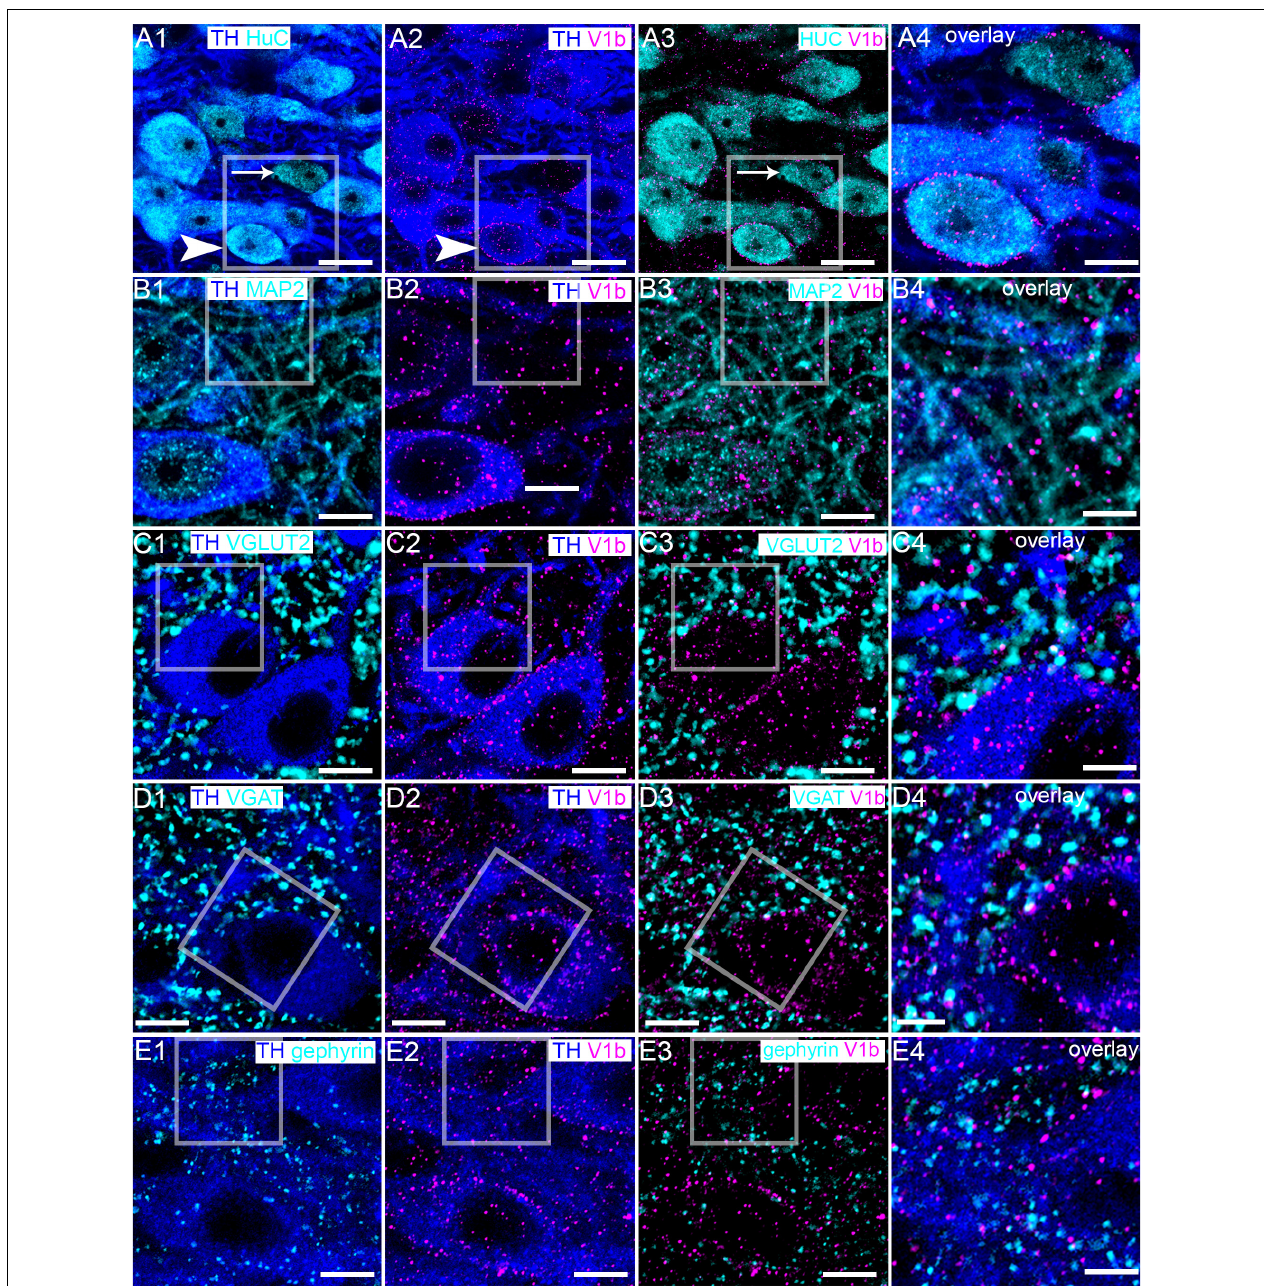
FIGURE 2 | V1b receptor is expressed on noradrenergic and non-noradrenergic LC neurons in close proximity to glutamatergic and GABAergic synapses. (A1) Shows immunoreactivity for TH (blue), a marker of noradrenergic neurons and HuC (cyan), a pan-neuronal marker. Thus, in this brain region, HuC identifies noradrenergic (arrowhead) and non-noradrenergic (arrow) neurons of the LC. (A2) Shows, in the same field of view, immunoreactivity for TH (blue) and V1b receptor (magenta), confirming its expression in LC noradrenergic neurons (arrowhead). V1b receptor signal presents as individual clusters concentrated on somatodendritic plasma membranes, typifying the expression pattern of a metabotropic receptor. (A3) shows, in the same field of view, immunoreactivity for V1b receptor (magenta) and HuC (cyan), confirming V1b receptor expression in LC non-noradrenergic neurons as well (arrow). (A4) Is an overlay and magnified view of the boxed area in (A1–A3) . (B1) Shows immunoreactivity for TH (blue), and microtubule associated protein 2 (MAP2) (cyan), a protein enriched in dendrites. (B2) shows, in the same field of view, immunoreactivity for TH (blue) and V1b receptor (magenta), which confirms V1b expression on dendritic compartments. (B3) Shows, in the same field of view, the association of immunoreactivity for V1b (magenta) with MAP2 (cyan), confirming V1b expression in dendritic compartments as well. (B4) Is an overlay and magnified view of the boxed area in (B1–B3) . (C1) Shows immunoreactivity for TH (blue), and vesicular glutamate transporter 2 (VGLUT2) (cyan), a protein enriched in glutamatergic axon terminals and used here to identify presynaptic domains of excitatory synapses. (C2) Shows, in the same field of view, immunoreactivity for TH (blue) and V1b receptor (magenta). (C3) Shows, in the same field of view, the association of immunoreactivity for V1b receptor (magenta) with VGLUT2 (cyan).